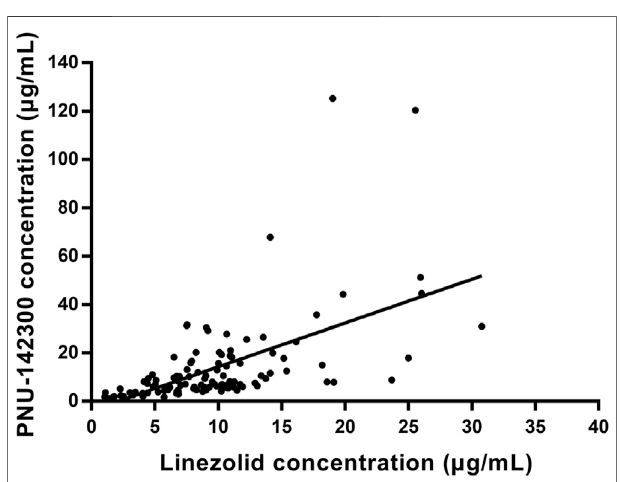
FIGURE 4 | Linear regression between linezolid and PNU-142300 concentrations. ( Y (cid:2) 1.811*X — 3.812, R 2 (cid:2) 0.3262, indicated that PNU- 142300 concentrations in paired samples were poorly correlated to linezolid concentrations).